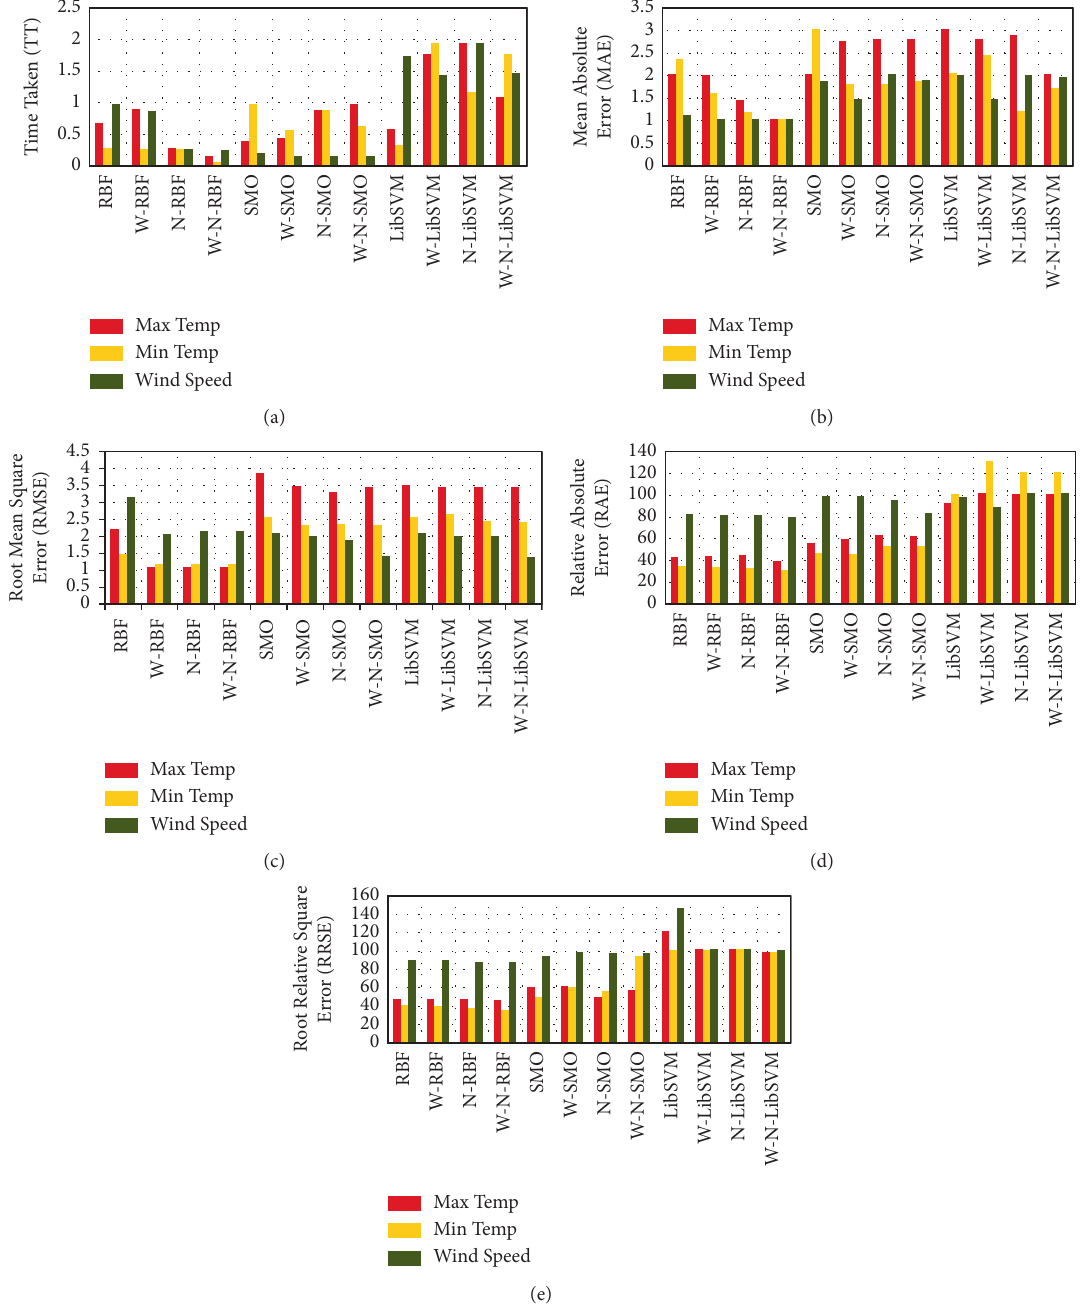
Figure 7: Comparison plot of forecasting errors for Chennai data. (a) TTcomparison. (b) MAE comparison. (c) RMSE comparison. (d) RAE comparison. (e) RRSE